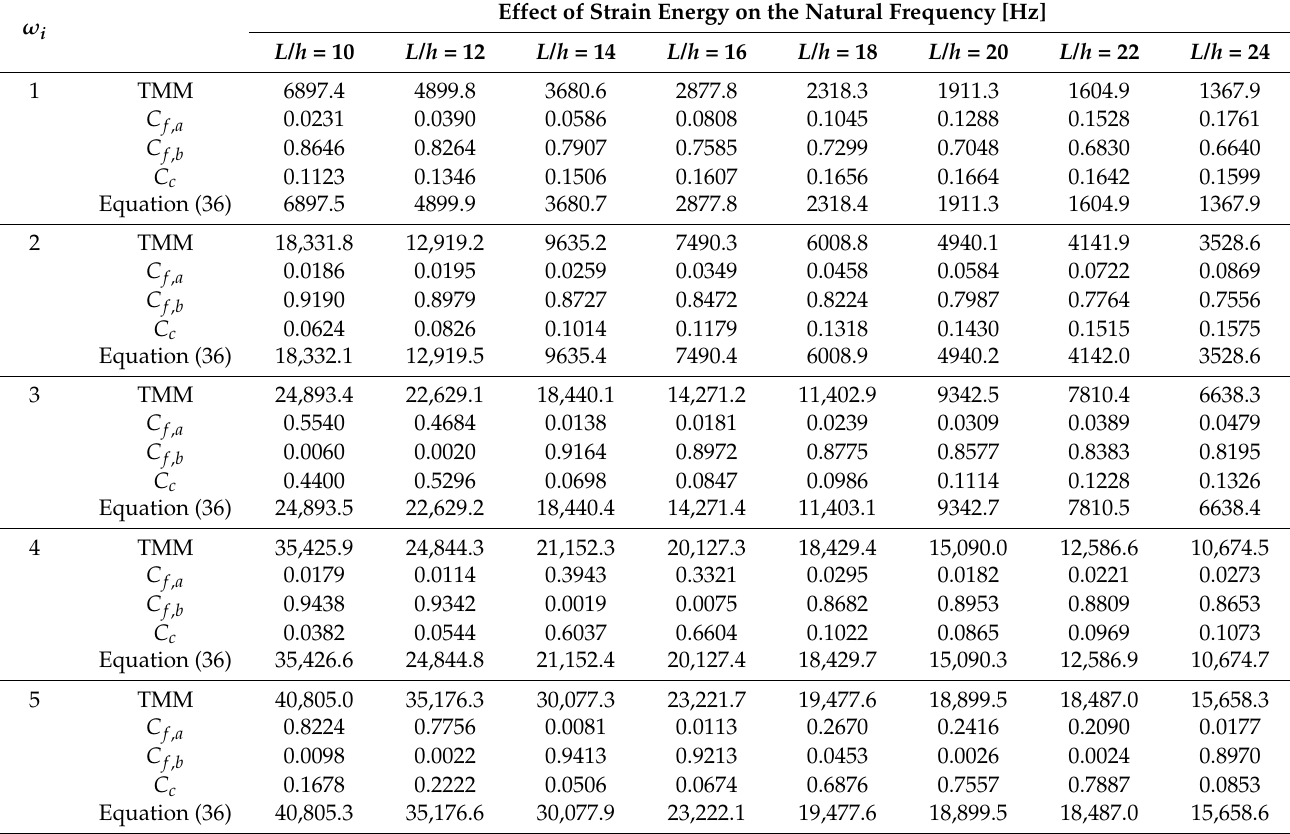
Table 9. Effect of strain energies on the natural frequencies of three-layered beams with the C-C end condition depending on the variation in L/h .